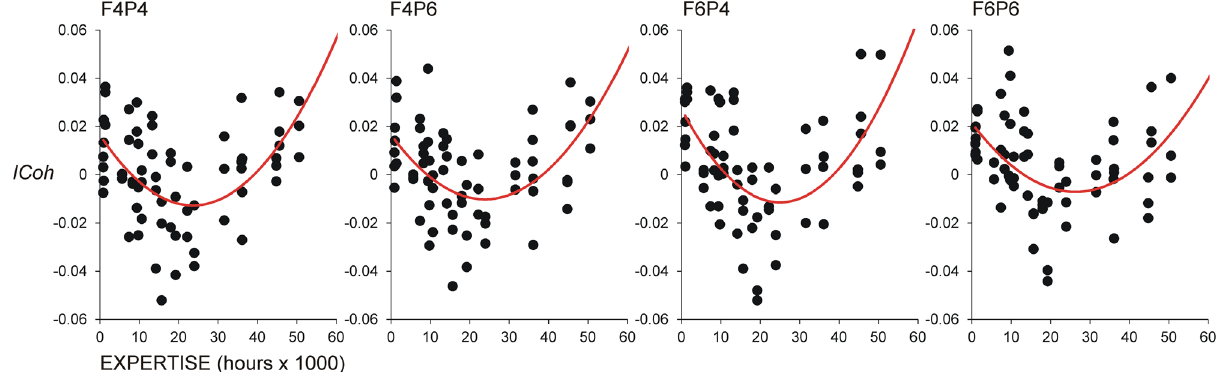
Figure 6. Regression analyses for intra-hemispheric connections in the right hemisphere for theta frequency range vs. meditation expertise. Individual difference ICoh values are included for FAM, OMM and LKM (meditation minus rest). Positive ICoh difference values reflect meditation-related increase. Right hemisphere pairs are indicated above each graph. Y-axis—non-dimensional ICoh difference values. U-shape dependency on meditation expertise indicating a most pronounced increase in synchronization in least and most experienced meditators is demonstrated.